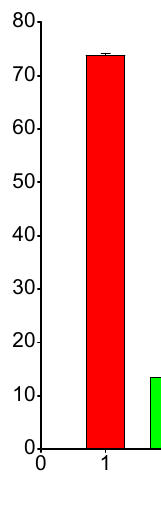
Figure 7. The relationship between extraction times and extraction rates of the TCBL polysaccharide.